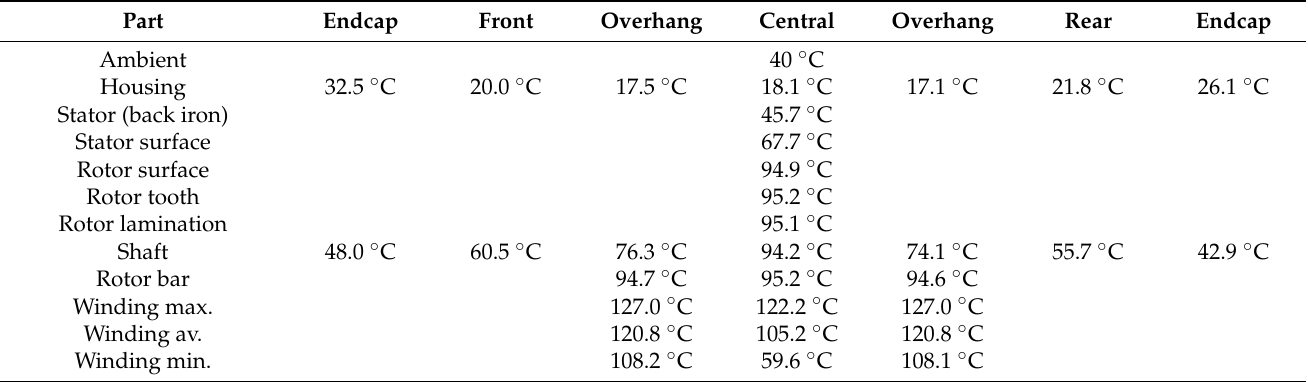
Table 13. Axial temperatures for water cooled motor (Alloy 195